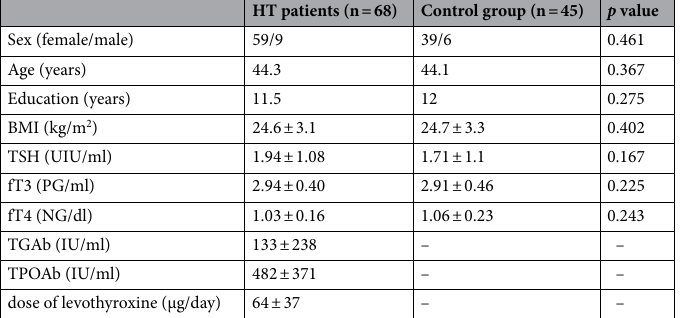
Table 1. Demographic and laboratory characteristics of HT patients and control